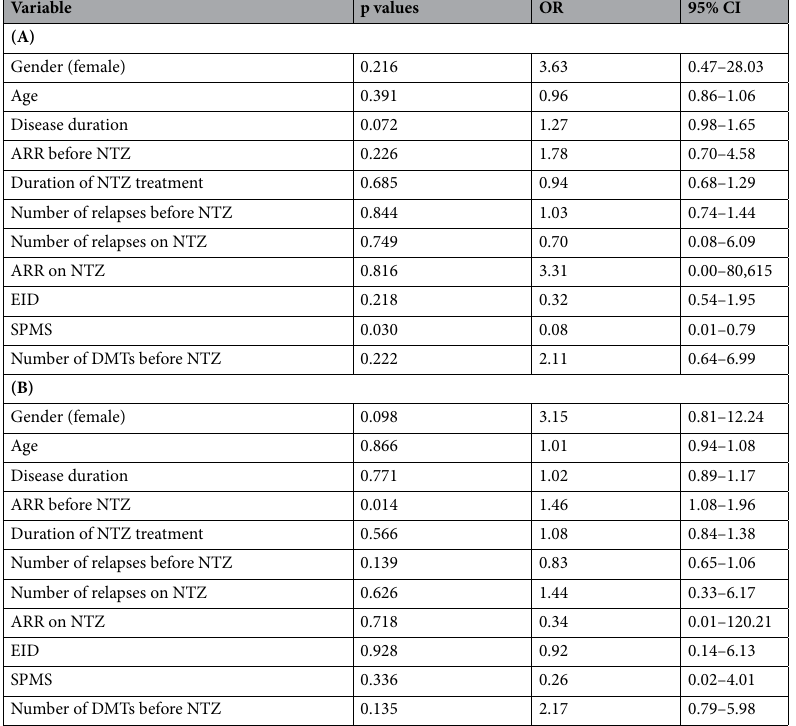
Table 4. Regression models for potential risk factors for disease reactivation (A, binomial logistic regression) and time to first relapse (B, Cox regression) after NTZ discontinuation. A: For binomial linear regression model patients who discontinued NTZ after ≥ 2 years of treatment duration were divided in patients with and without occurring disease reactivation expressed by relapses and/or MRI activity after NTZ discontinuation. This model focused on risk factors whether there was a disease reactivation after stop of NTZ or not. B: In addition, Cox regression model was performed in order to investigate potential risk factors for time to first relapse after NTZ withdrawal. ARR annualized relapse rate, EID extended interval dosing before discontinuation, SPMS secondary progressive multiple sclerosis, DMT disease modifying treatment, OR odds ratio, CI confidence interval. Both tables show significances (p-values) and odds ratio for each analysed potential risk